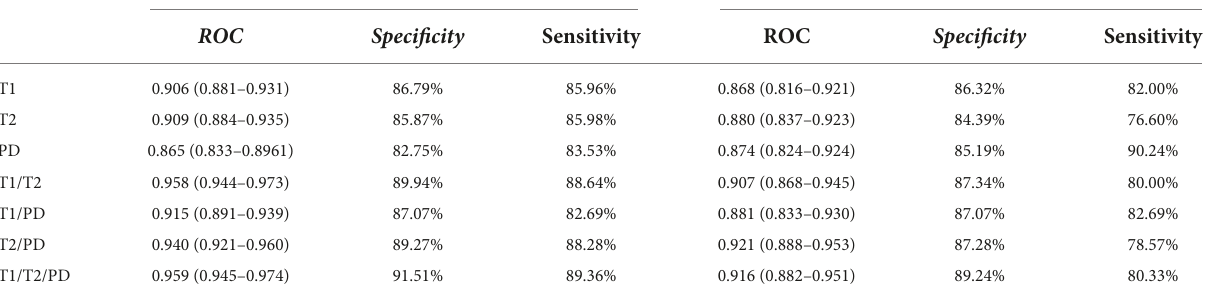
TABLE 2 Specificity and sensitivity of 7 prediction